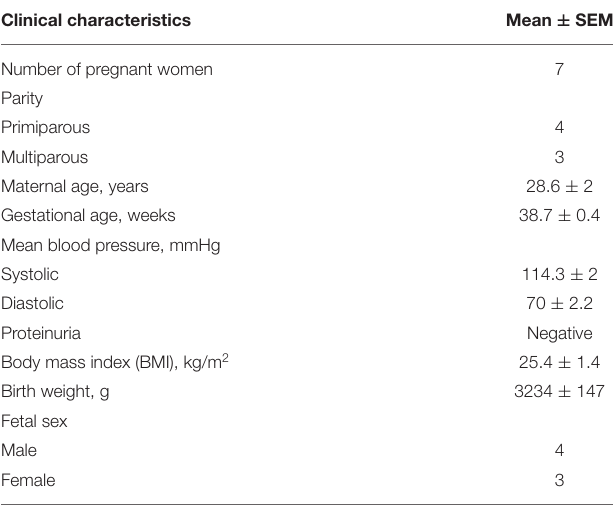
TABLE 1 | Clinical characteristics of normal pregnant women. Clinical